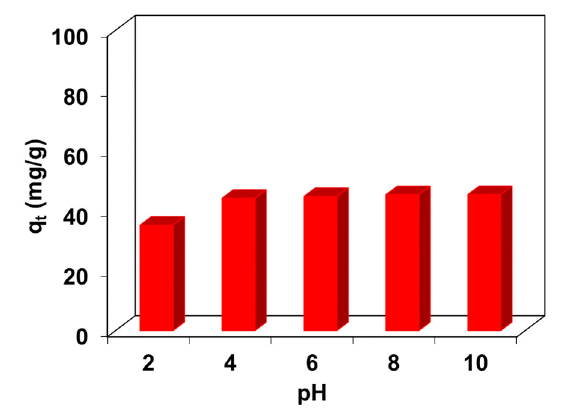
Figure 1. Effect of solution pH on the BR46 uptake from the solution of the initial concentration 100 mg/L.